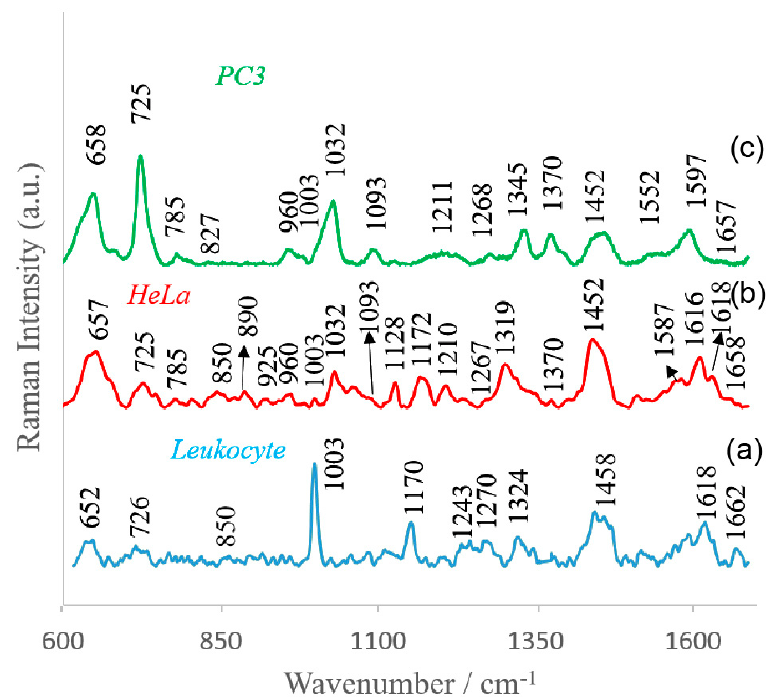
Figure 4. Averaged and normalized SERS spectra of ( a ) leucocytes, ( b ) cervical carcinoma (HeLa), and ( c ) prostate cancer (PC3) cells recorded on polymer-based SERS platform. Experimental conditions: excitation at 785 nm, laser power at 1.5 mW, and 45 seconds integration time. Each SERS spectrum was obtained by averaging at least 25 single spectra from different places on the SERS substrate.